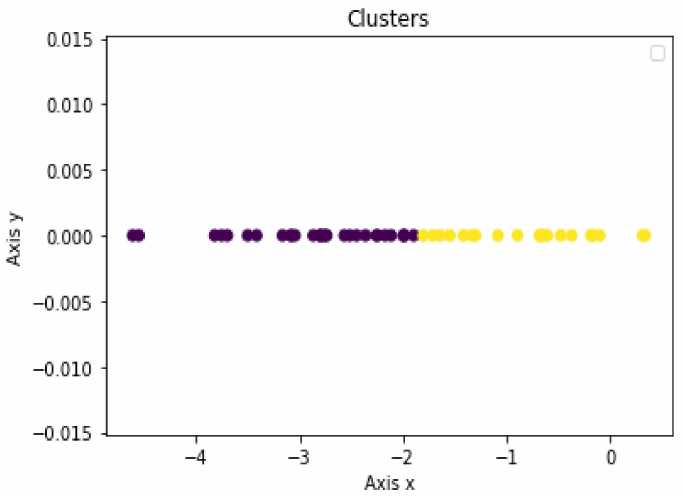
Figure 6. Distribution of predicted K-means clustering result using LD1 as input.